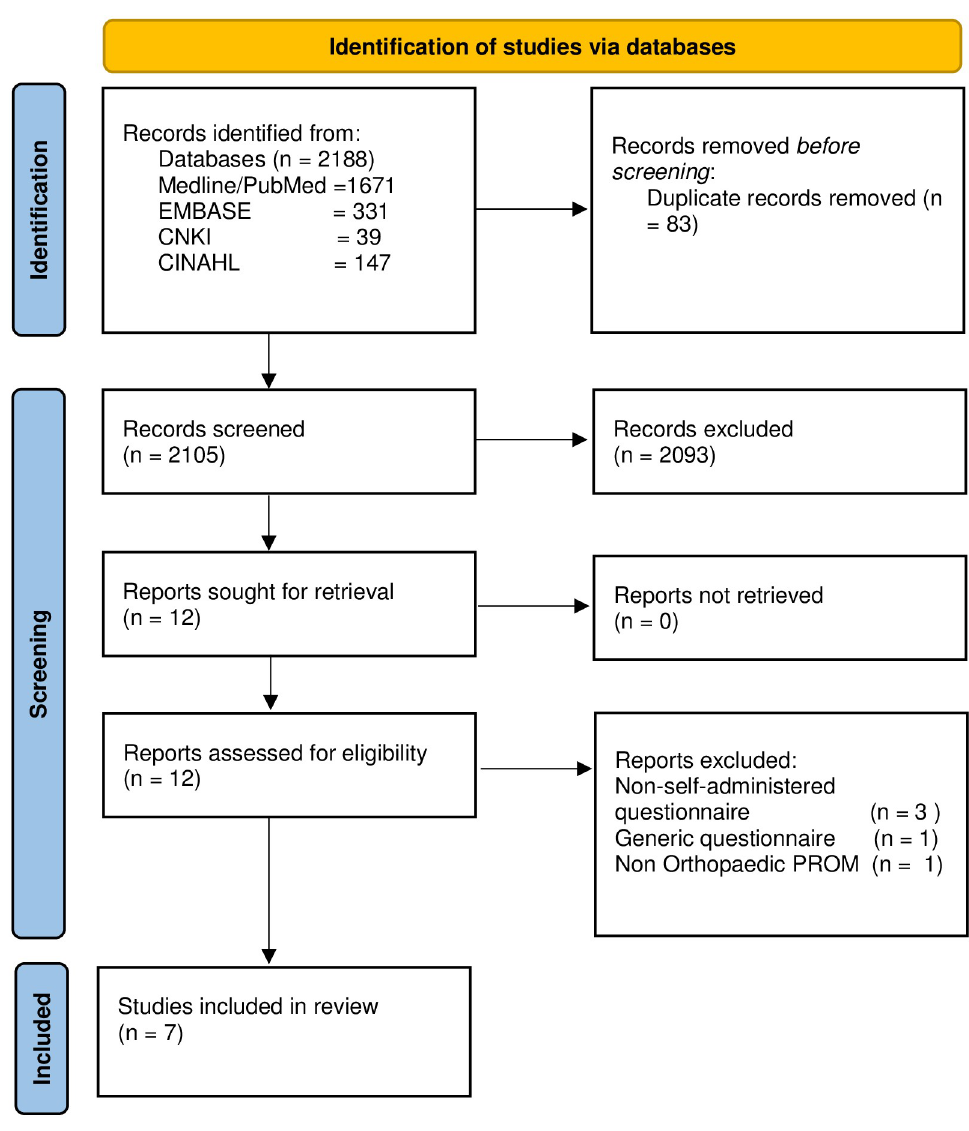
Fig 1. PRISMA flow chart—Systematic literature